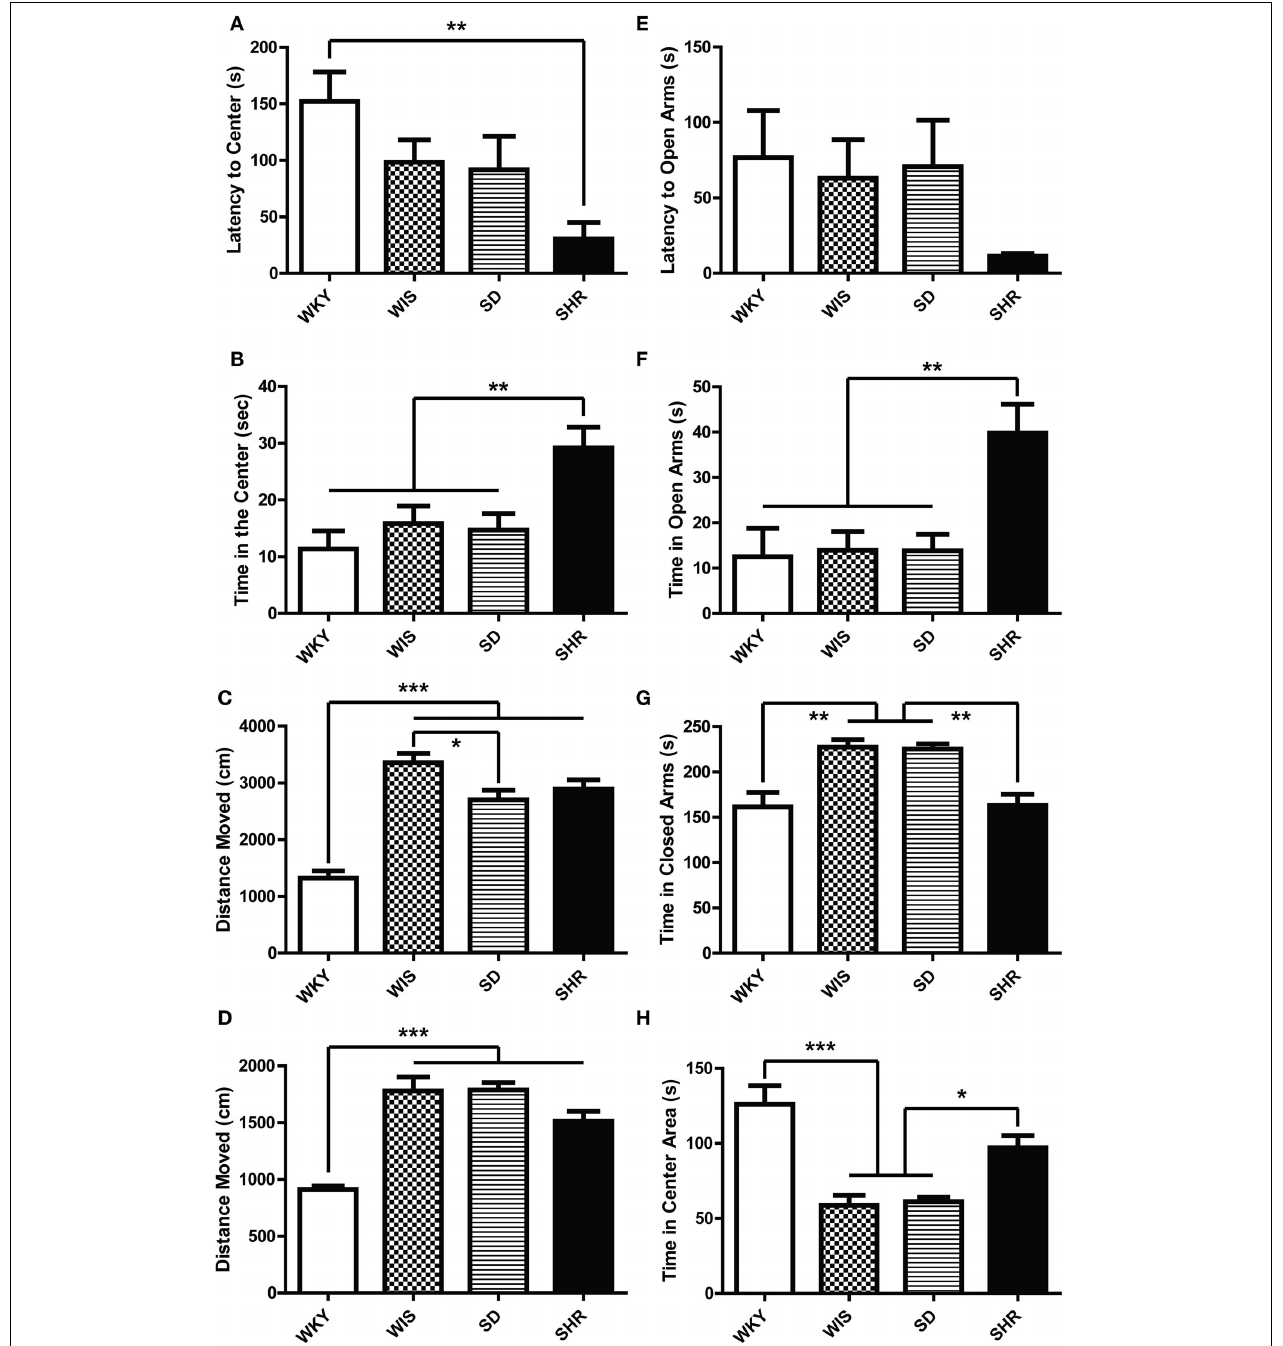
FIGURE 3 | Anxiety-like behavior of four rat strains in the open field test and elevated plus maze. Adult male rats from four strains—Wistar Kyoto (WKY), Wistar (WIS), Sprague–Dawley (SD), and Spontaneously Hypertensive Rat (SHR)—were compared in two tests of rodent anxiety: the open field (A–C) and the elevated plus maze (D–H) . SHR showed the least anxiety with shortest latency to visit the center of the OF (A) , and longer time spent there (B) compared to all other strains. WKY rats, on the other hand, exhibited the least locomotion (C) . In the elevated plus maze, SHR again showed the least